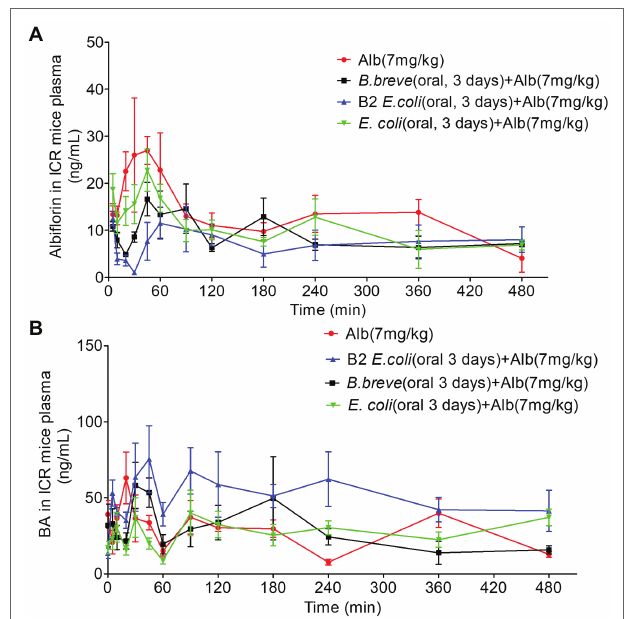
FIGURE 5 | Pharmacokinetic study of albiflorin in vivo . (A) Plasma concentration-time profiles of albiflorin (Alb) in four groups of mice (oral 3 days, NS, Bifidobacterium breve 1 × 10 10 CFU/day, Escherichia coli with B2 1 × 10 10 CFU/day, and E. coli 1 × 10 10 CFU/day) after oral administration (7 mg/kg). (B) Plasma concentration-time profiles of Benzoic acid (BA) in four groups of mice (oral 3 days, NS, B. breve 1 × 10 10 CFU/day, E. coli with B2 1 × 10 10 CFU/day, and E. coli 1 × 10 10 CFU/day) after oral administration of albiflorin (7